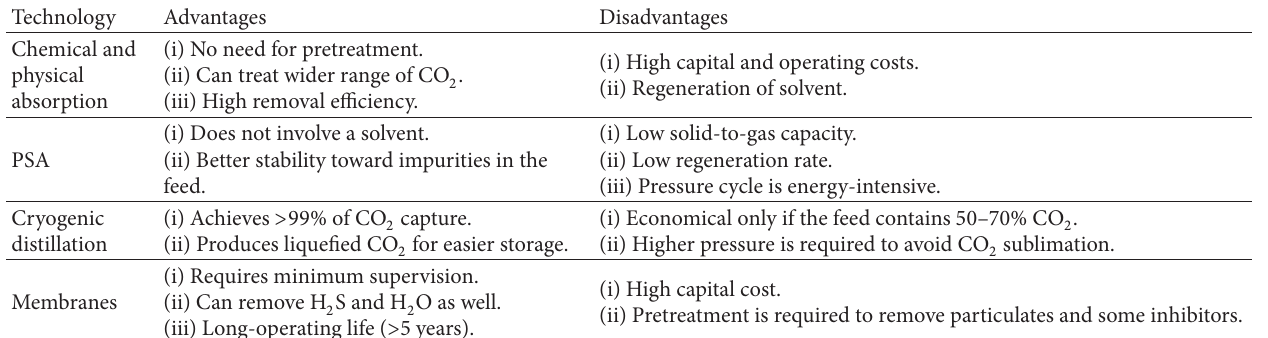
Table 3: Current technologies for carbon dioxide